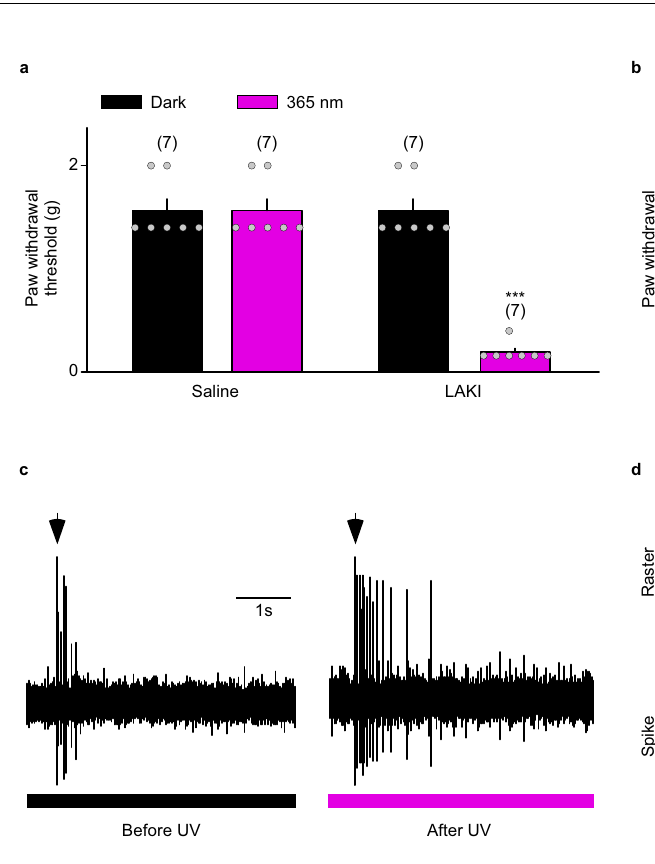
independent experiments. Statistical signi fi cance was determined by a mixed- effects model with repeated measures followed by Holm – Sidak ’ s post-test (*** p <0.001). c Representative spinal dorsal horn neuron responses evoked by electricalstimulation(4mA)beforeandafter20silluminationat365nm(magenta) in mice injected with LAKI (100 µ M, 15 µ L). d Raster plot and superimposed post- stimulus histogram of dorsal horn neurons before (black) and after illumination at 365nm (magenta) in mice injected with LAKI (100 µ M, 15 µ L). Data were repre- sented as mean±SEM. The numbers of mice are indicated in parentheses on the